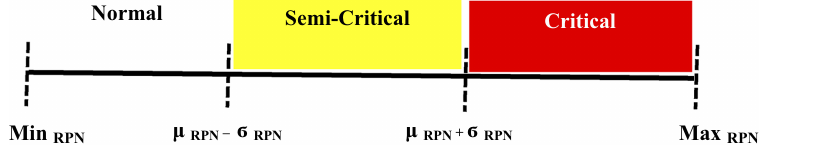
Table 2. Ranking the risk assessment criteria